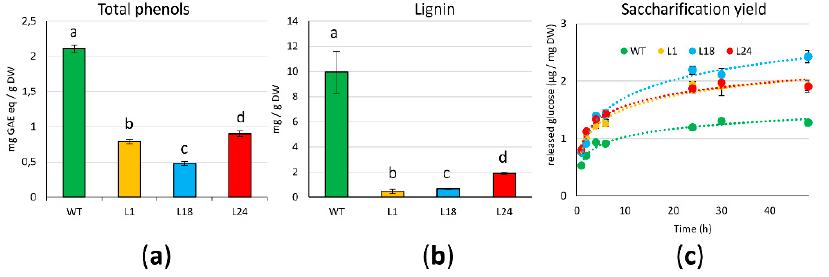
Figure 2. Phenols/lignin content and saccharification yields of 21 days-old calluses: ( a ) Folin–Cio- calteu’s quantification of total phenols, expressed as mg of GAE (Gallic Acid Equivalents)/g dry weight (DW) ± S.D; ( b ) quantification of lignin via thioglycolic acid (TGA) derivatization. Bars indi- cate means ± S.D. of three biological replicates. Different letters above bars indicate statistically sig- nificant differences ( p < 0.01); ( c ) saccharification yields expressed as mean values of µg released glucose/mg DW ± S.D.